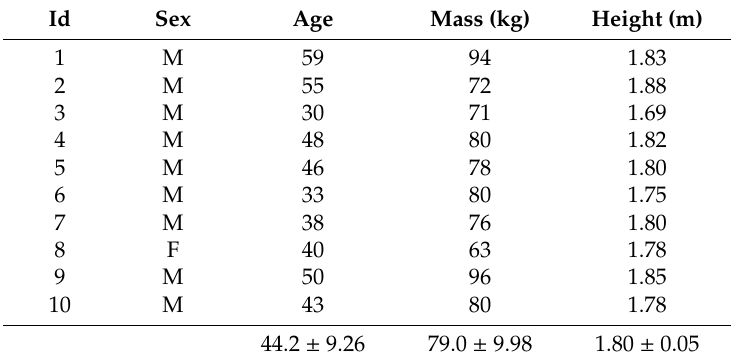
Table 1. Demographic data of healthy subjects recruited for the gait